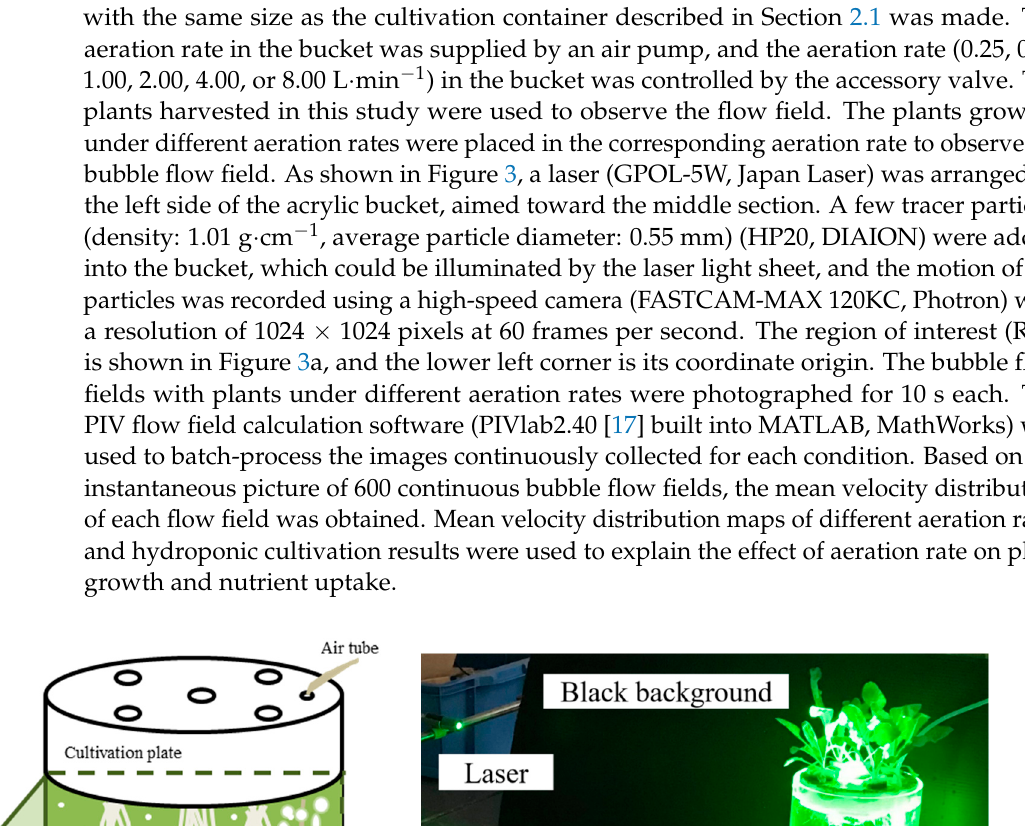
Table 2. The conversion of aeration rate to aeration intensity.